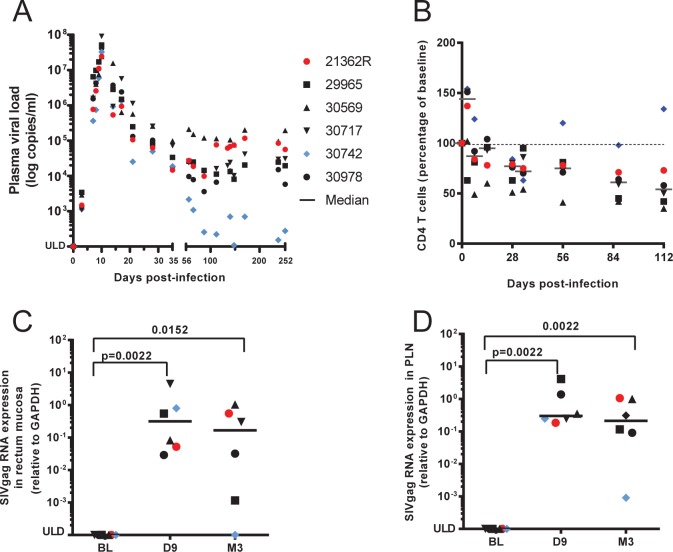
Infection of six cynomolgus macaques with SIVmac251 and establishment of chronic infection.(A) vRNA load in plasma. (B) Evolution of total CD4 T cell numbers in the blood over time (percentage of baseline). (C) vRNA in RB. (D) vRNA in PLNs. ULD = under the limit of detection. P values are given for non-parametric Wilcoxon rank sum test and was considered significant if p < 0.05.